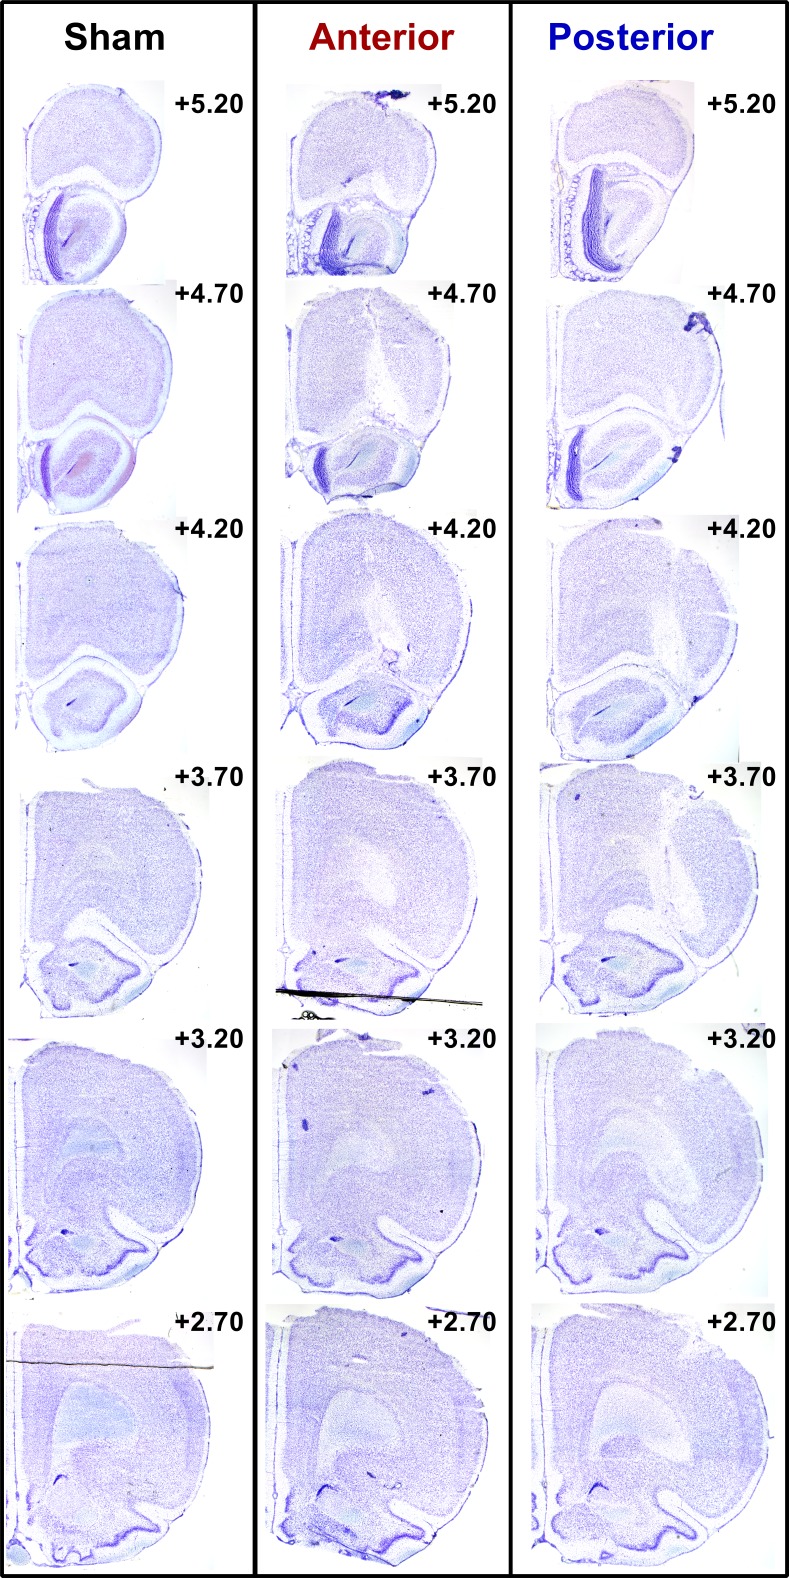
Representative OFC lesion damage across the anterior-posterior plane within the same rat from the sham (left), anterior (middle), and posterior lesion groups.Coronal sections are identified in mm relative to bregma (Paxinos and Watson, 1997).